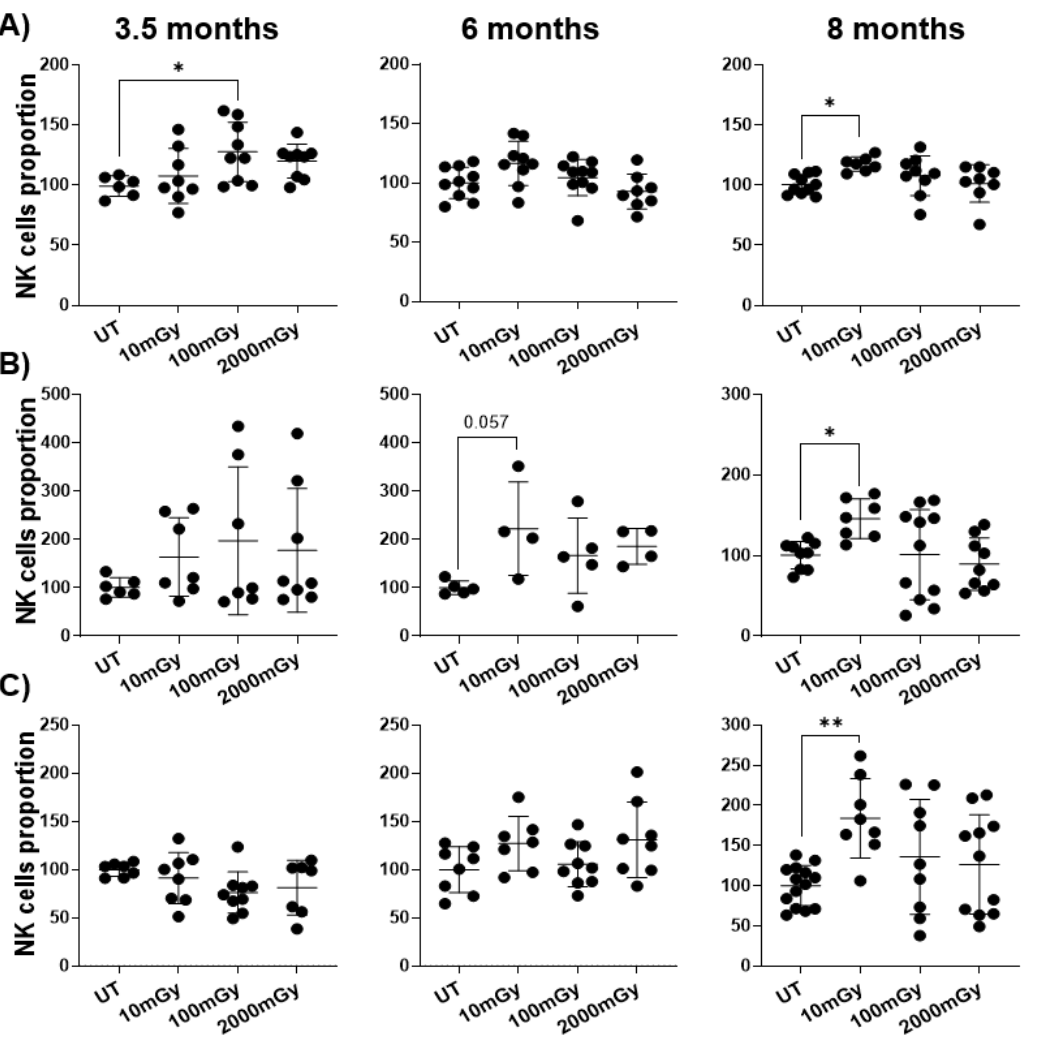
Figure 2. LDR increases NK cell proportion. Single-cell suspensions were generated from different organs of mice sacrificed at indicated time points after radiation exposure. Cells were stained with NK cell surface marker, and relative proportion of NK cells was assessed in ( A ) spleen, ( B ) lungs, and ( C ) mammary glands of untreated control and LDR-exposed mice by flow cytometry. Y-axis represents the relative percentage of NK cells in the total population of mononuclear cells. Percent NK cells in untreated mice were set to 100%. Data represent mean + SD. * p < 0.05, ** p < 0.01.